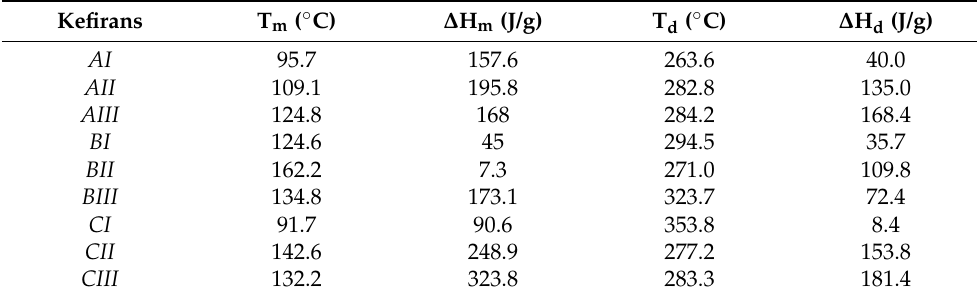
Table 1. Thermal properties of cow (A), buffalo (B), and goat (C) kefirans extracted with cold water (I), hot water (II), and mild heat-ultrasound